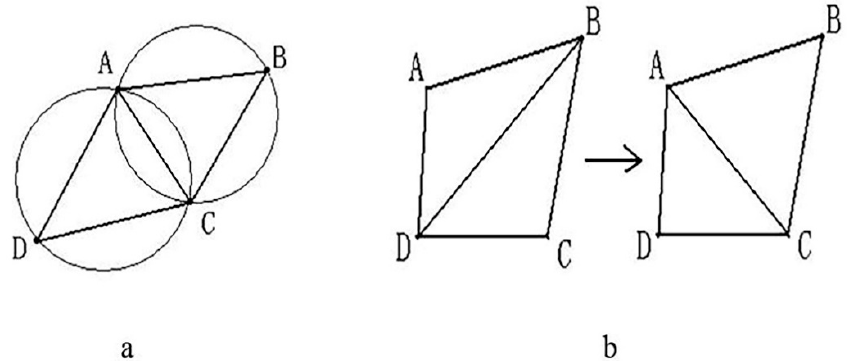
Figure 4. ( a ) Empty characteristic, ( b ) Minimum angle maximization characteristic. A, B, C, D are any four points in space.